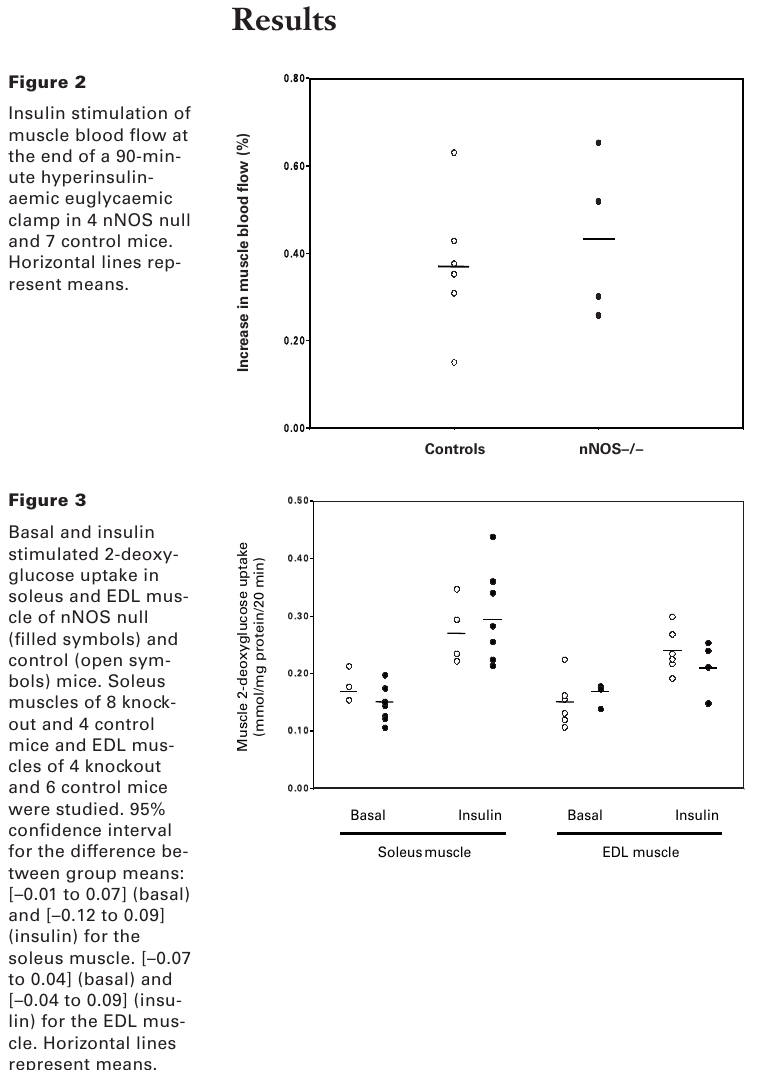
Figure 3 Basal and insulin stimulated 2-deoxy - glucose uptake in soleus and EDL mus- cle of nNOS null (filled symbols) and control (open sym- bols) mice. Soleus muscles of 8 knock- out and 4 control mice and EDL mus- cles of 4 knockout and 6 control mice were studied.